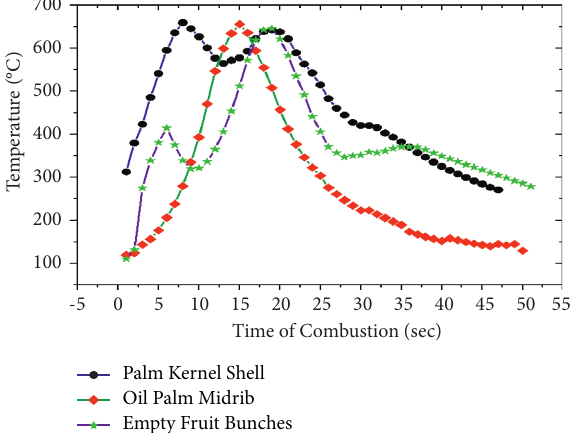
Figure 14: Profile temperature for different fuels at the measurement (M-IV).